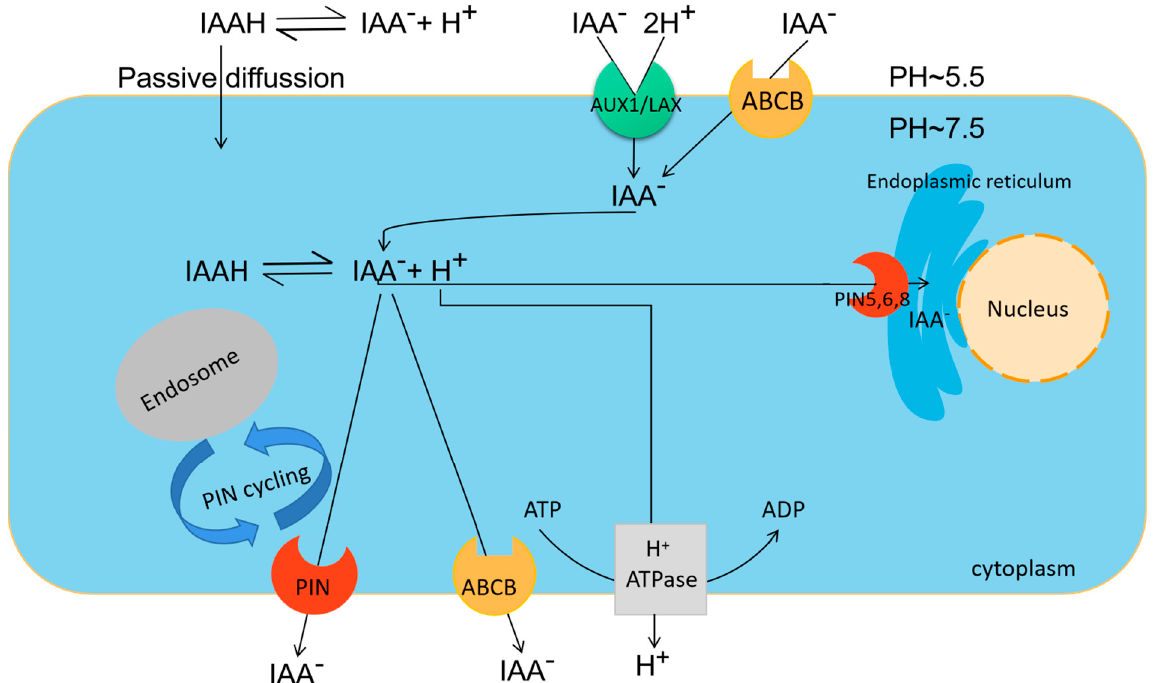
Figure 2. Chemiosmotic model for polar auxin transport. Auxin transporters include PIN, AUX1/LAX, and ABCB. Protonated IAA (IAAH) enters cells through passive transport, while auxin anion (IAA − ) and H+ have low lipophilicity and permeability, and can only enter cells through AUX1/LAX influx carriers. In cells with strong alkalinity, IAA dissociates and needs to leave the cell through PIN or ABCB efflux transporter proteins. The polar localization of PIN protein determines the flow direction of auxin. Some intracellular IAA may be transported to the endoplasmic reticulum through PIN5, PIN6, and PIN8 to regulate the homeostasis and metabolism of auxin. PIN protein can be recovered by endocytosis and reinserted into lipid bilayer. The arrows indicate the direction of the auxin flow (refer to Robert et al., 2009 [36]; Friml et al., 2010 [37]; Wang et al., 2018 [38]).